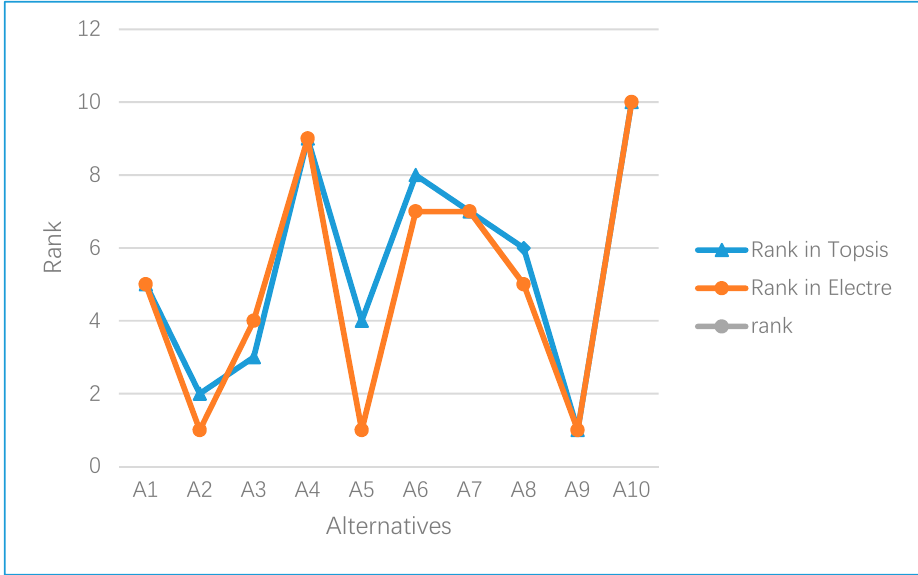
Figure 5. The pictorial representation of the TOPSIS and ELECTRE I rankings.